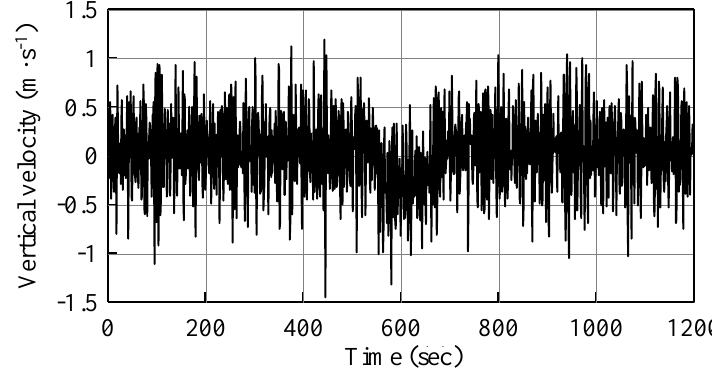
Figure 10. An example of the GPS output vertical velocity with signal drifting.